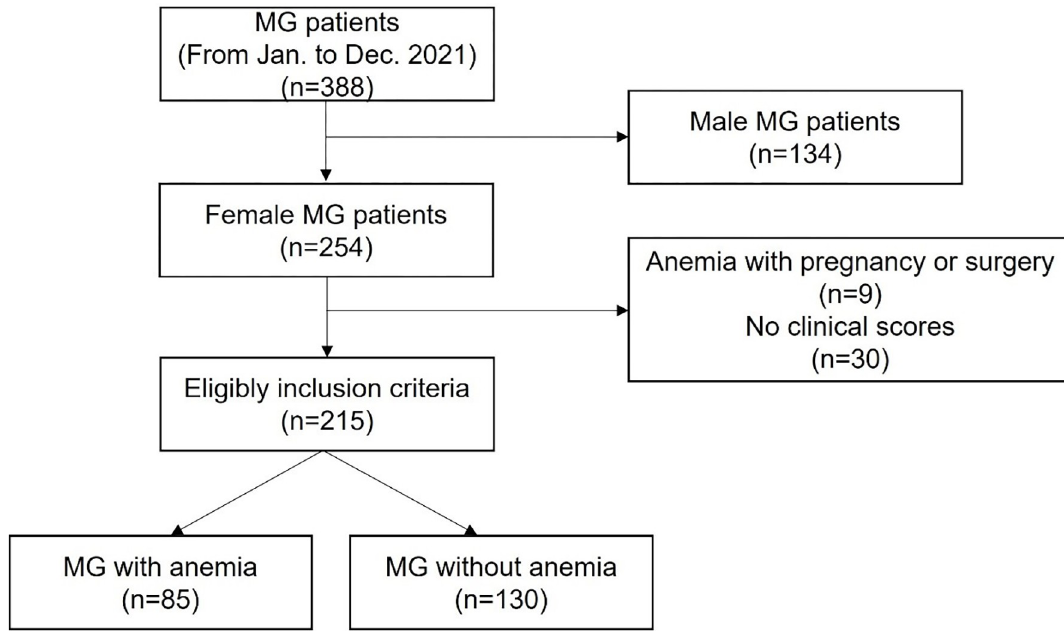
Fig 1. Study flow. MG, myasthenia